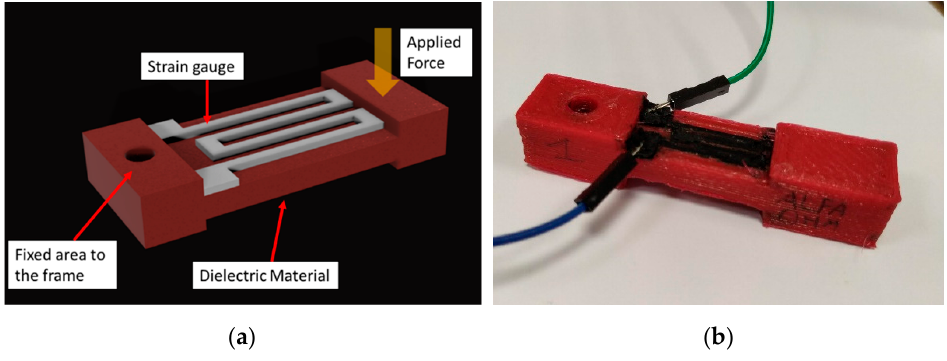
Figure 1. ( a ) 3D model and ( b ) realization of the proposed strain sensor.